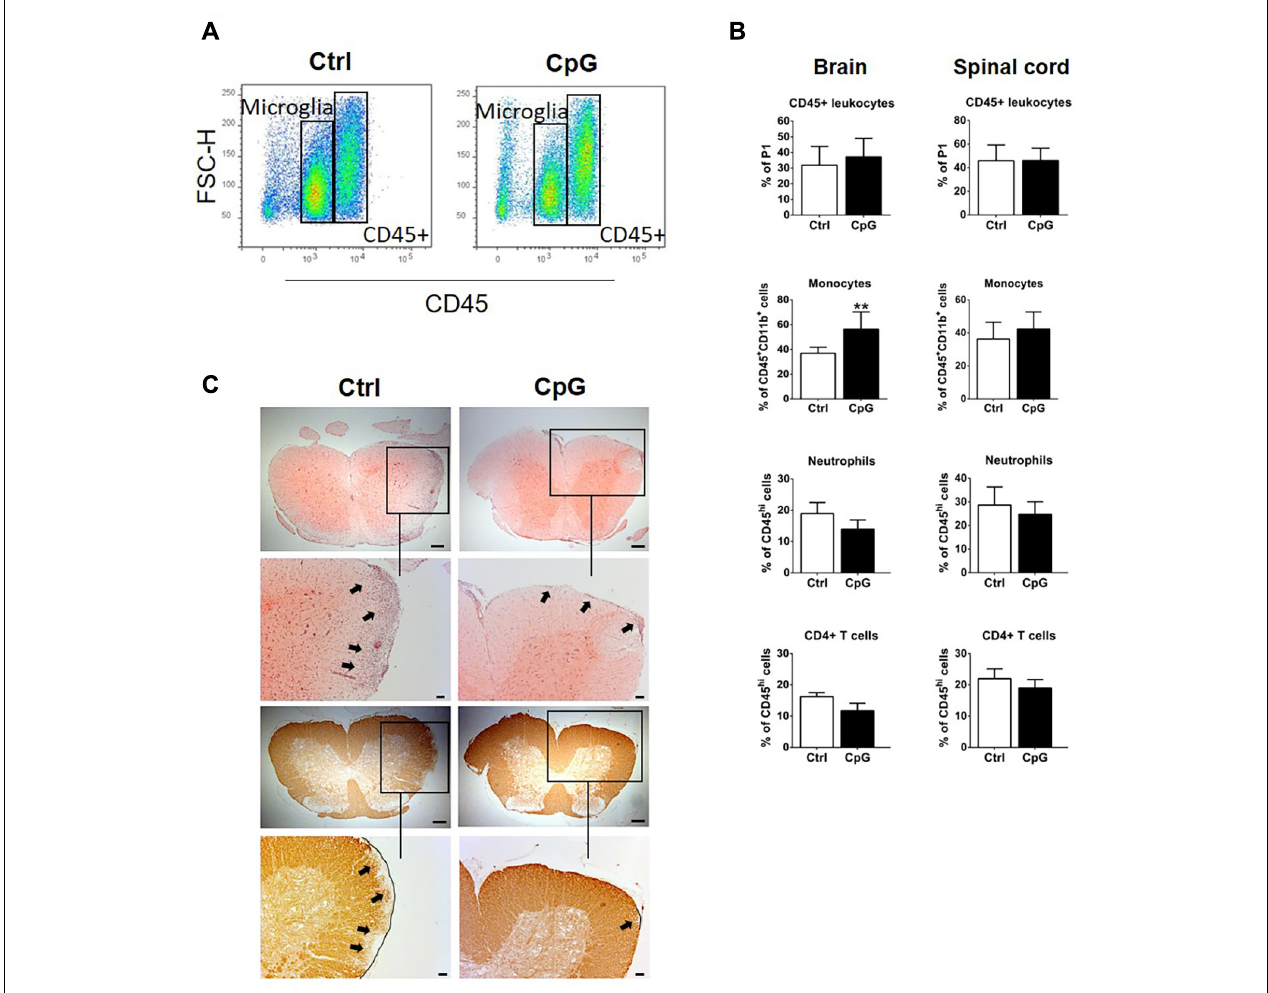
FIGURE 6 | Intrathecal CpG induced recruitment of monocytes to the CNS and reduced demyelination in experimental autoimmune encephalomyelitis (EAE). (A) Flow cytometry profiles of mice with EAE treated with intrathecal CpG or control (ctrl). CD45high leukocyte populations are distinguished from CD45dim microglia. (B) Quantitative flow cytometric analysis comparing the percentage of CD45+ leukocytes, (CD45 hi CD11b hi GR1 low / - F4/80 + ) monocytes, neutrophils (CD45 hi CD11b hi GR1 hi F4/80 - ), and CD4+ T cells (CD45 hi CD11b low / - TCR β + CD4 + ) ( n = 6–8 per group). Results were analyzed using the two-tailed Mann–Whitney U -test. (C) Representative images of spinal cord sections of mice with EAE stained with H&E and anti-MOG antibody. Boxes show selected areas of the spinal cord sections with higher magnification. Arrows highlight infiltration or loss of MOG. Scale bars: 200 and 100 µ m. Data are presented as means ± SD. ** p < 0.01.